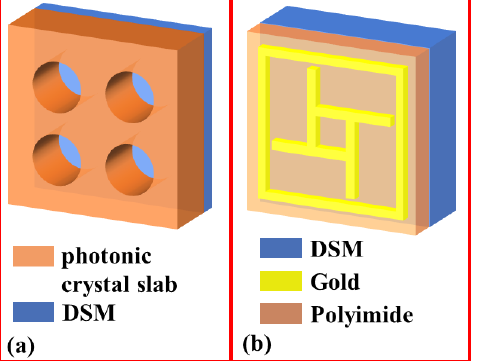
Figure 16. DSM-based metamaterial absorbers. ( a ) Photonic slabs with a thick DSM film [172]; ( b ) bulk DSM film layer [173].